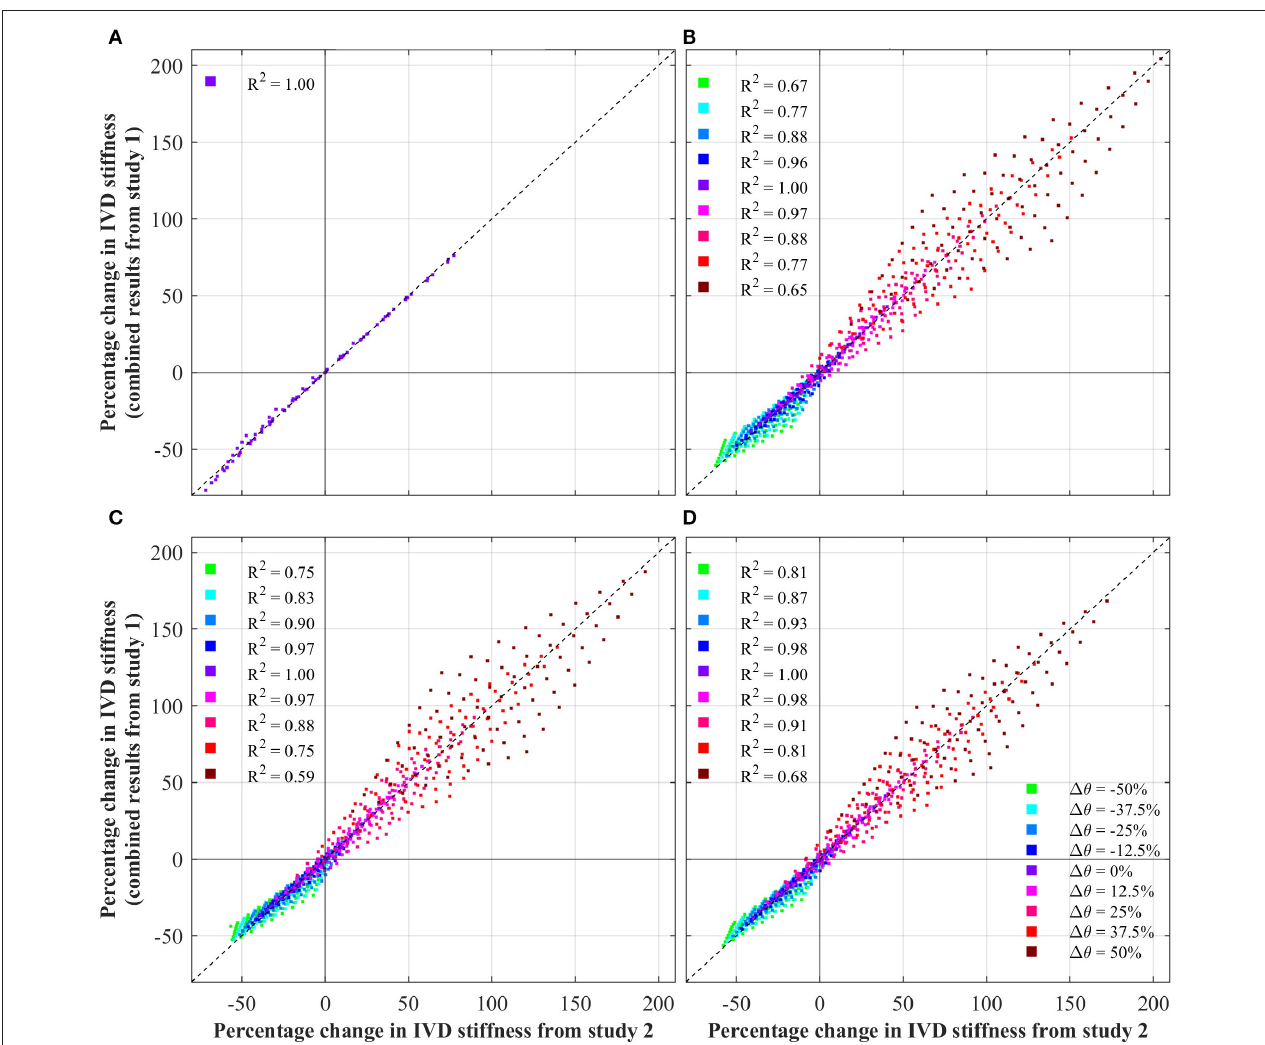
FIGURE 5 | Test of independence of IVD parameters, showing the change in IVD stiffness from the combined study (study 2) against that predicted by Equation (1). Note, in the case of axial rotation, ground matrix C 10 was not a significant variable, and thus was not modified. For ease of interpretation, each data points is colored based upon its 1θ . Additionally, the coefficient of determination (R 2 ) is shown for each θ , against the fit indicated by the dashed black line. (A) Axial rotation. (B) Flexion. (C) Extension. (D) Lateral